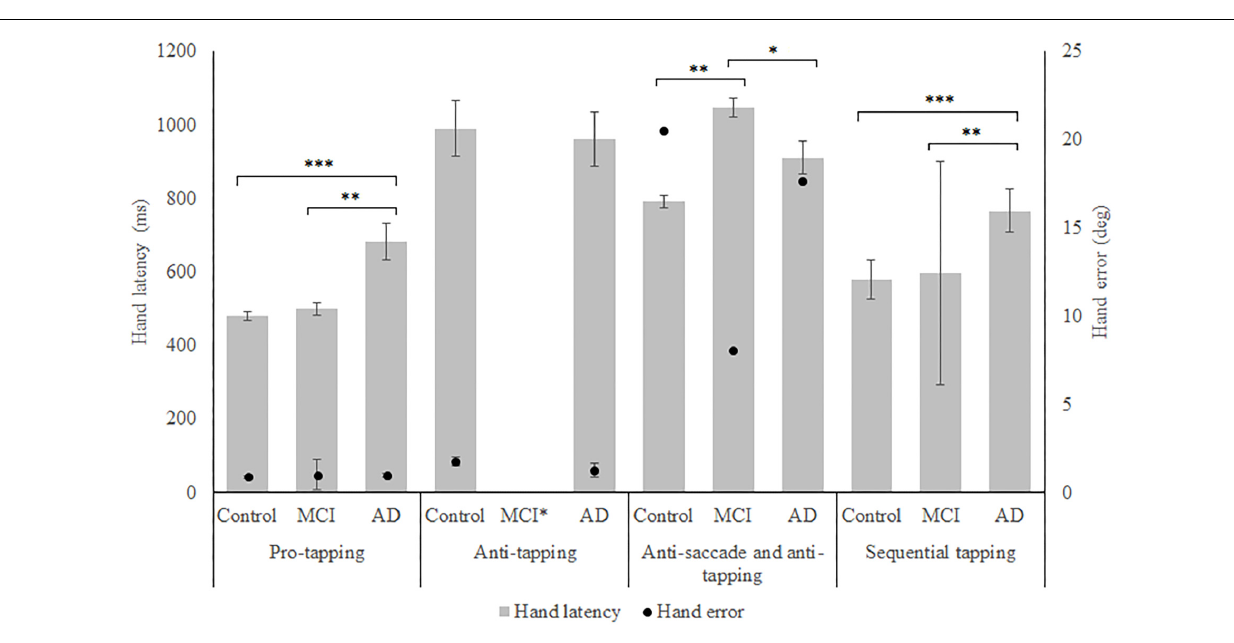
FIGURE 3 | Mean performance on hand latency and hand error for all groups, on all tasks. Error bars represent standard error. Significant differences for the anti-saccade anti-tapping task indicate differences for hand error; other indicated differences are for hand latency. Significant differences were indicated